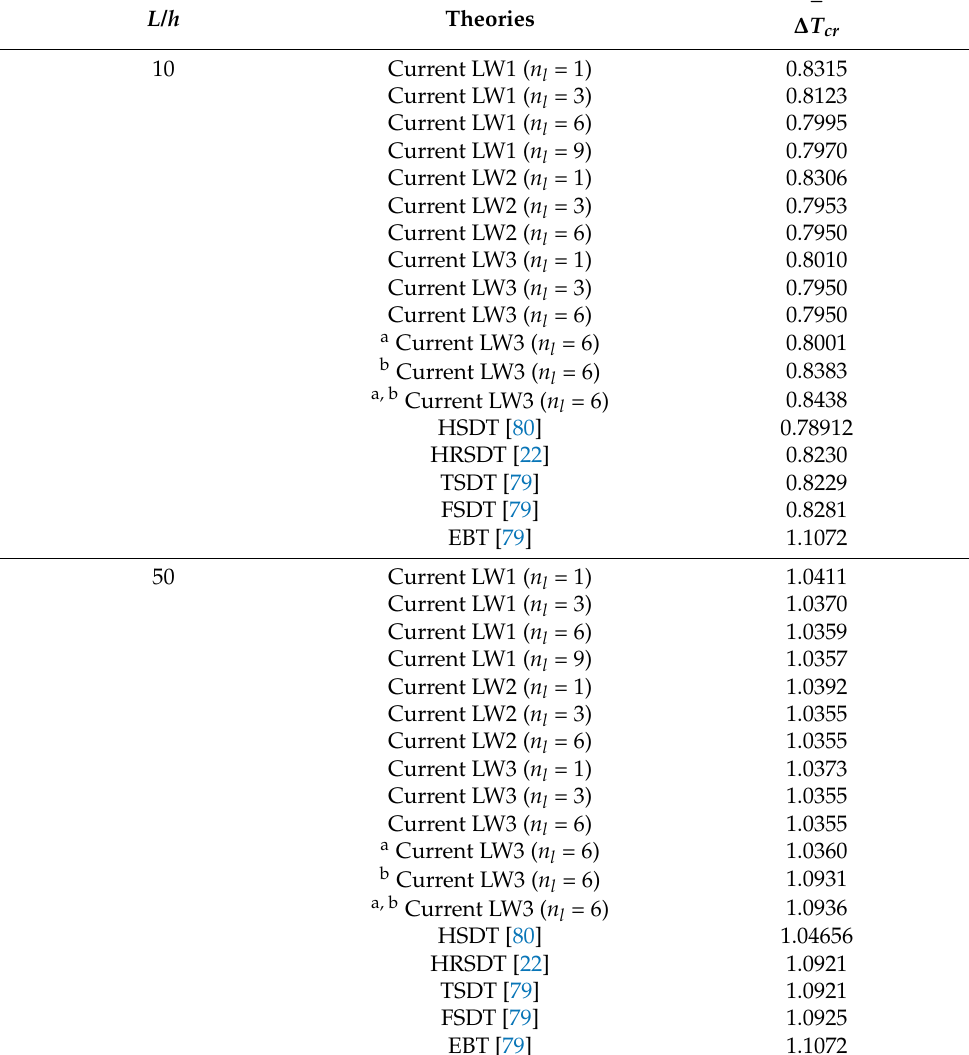
Table 1. Convergent study of critical temperature parameter solutions of simply supported, laminated (0 ◦ /90 ◦ /0 ◦ ) beams under a uniform temperature change ( α 2 / α 1 = 3, E 1 / E 2 =